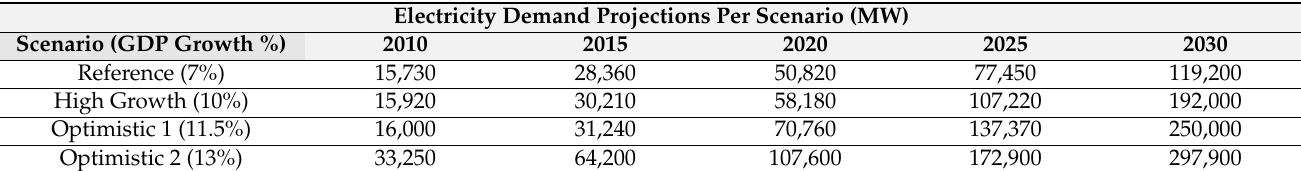
Table 1. Energy demand projections for Nigeria. (Data taken from: [16].